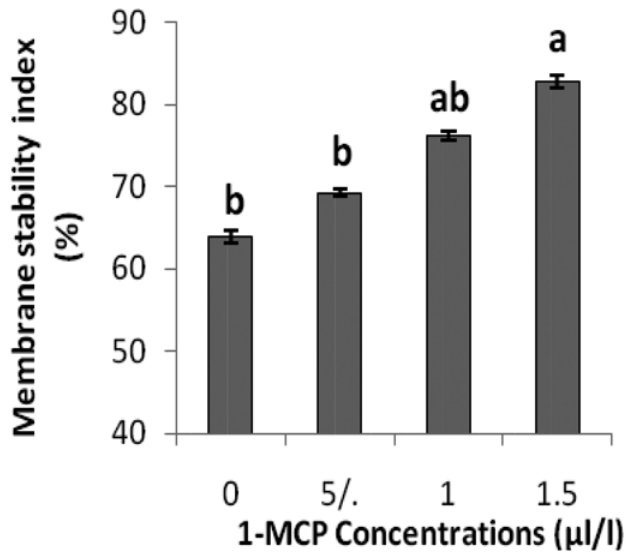
Fig. 2 - Effect of 1-MCP on petal membrane stability of carnation cv. Fortune. Data are means with standard errors (n=3).